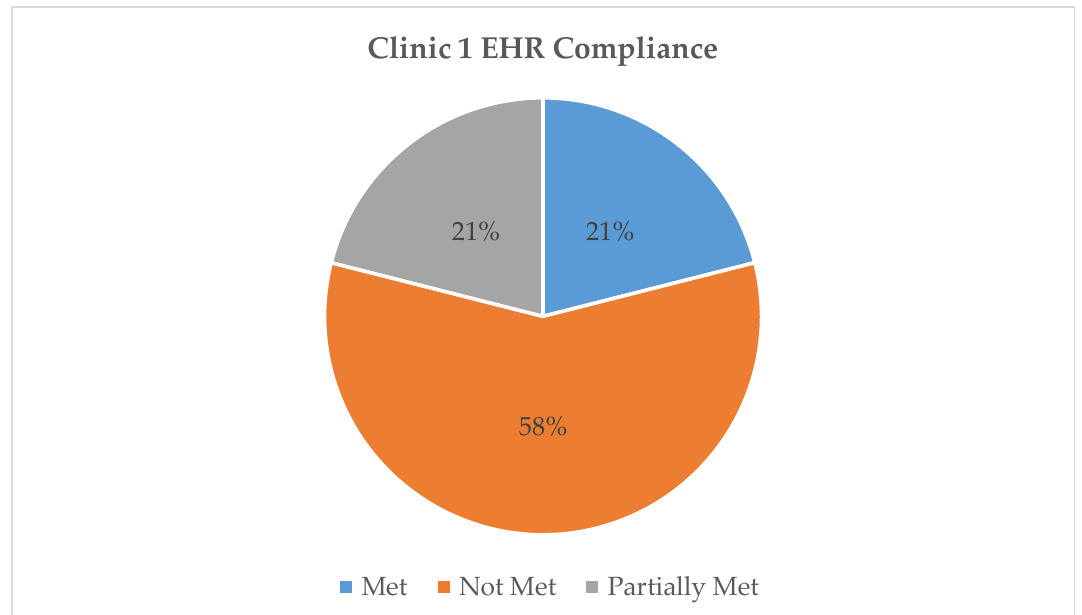
Healthcare 2019 , 7 , x FOR PEER REVIEW Figure 2. Clinic 1 electronic health record (EHR) compliance with AAP recommendations.